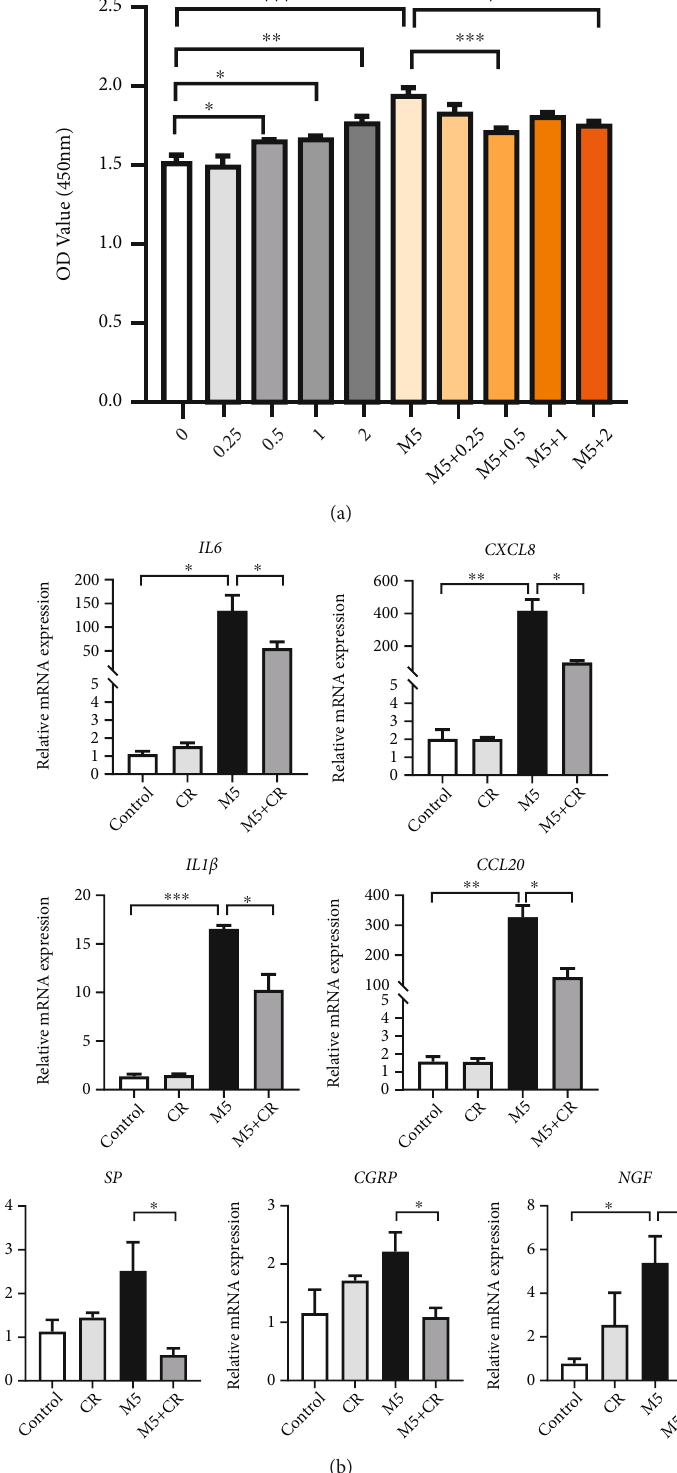
Figure 6: CR treatment regulated cell viability and function of M5-induced keratinocytes in vitro . M5 (10ng/ml) was used to stimulate NHEKs with or without CR treatment ((a): 0, 0.25 μ g/ml, 0.5 μ g/ml, 1 μ g/ml, and 2 μ g/ml; (b): 0.5 μ g/ml). (a) Cell viability was measured by using CCK-8 ( n = 4 ). (b) The mRNA expression of IL-6 , CXCL8 , IL-1 β , CCL20 , SP , CGRP , and NGF was detected by RT-qPCR ( n = 3 ). The relative